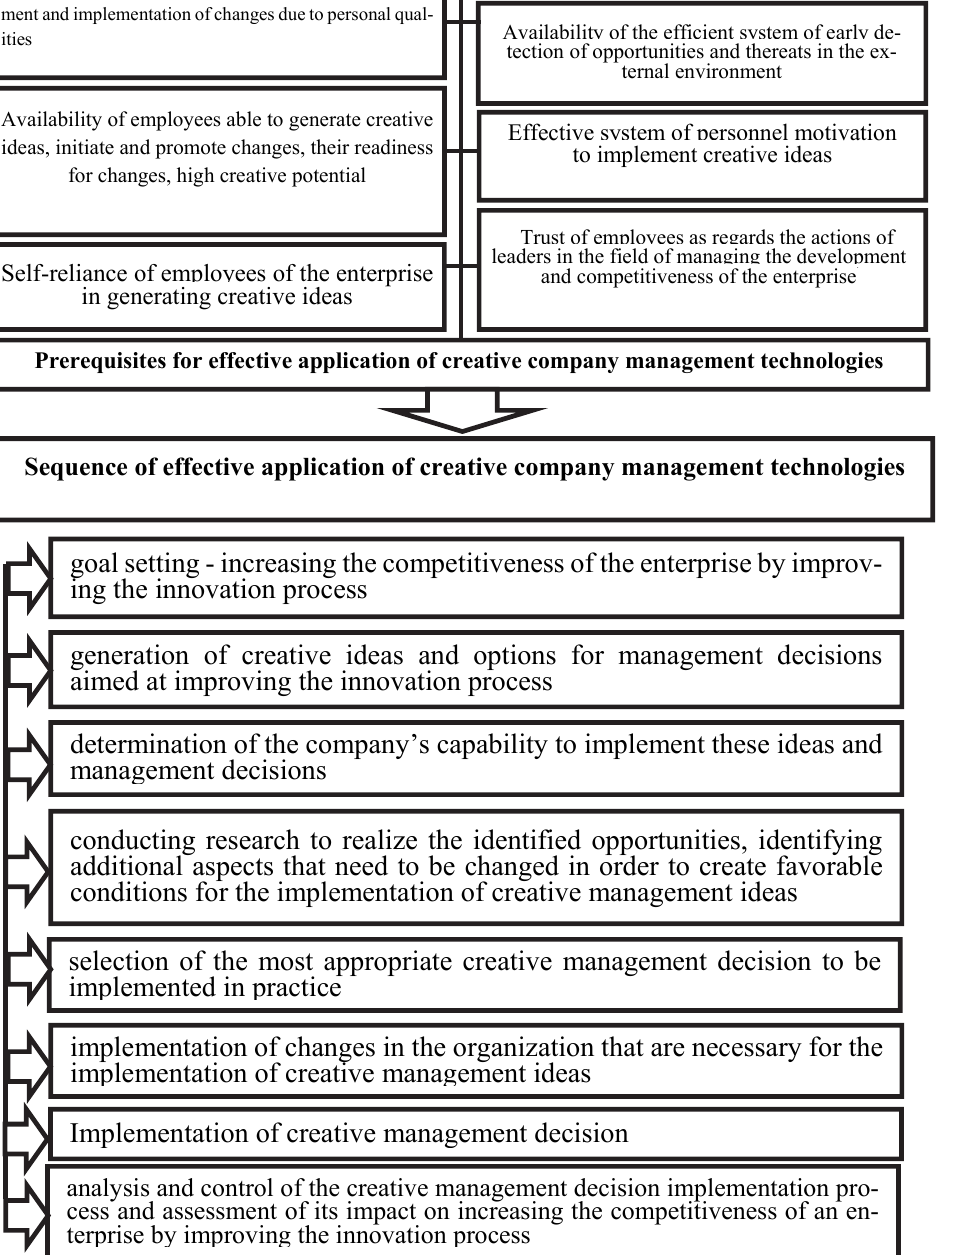
Fig. 3. Prerequisites and sequence of effective application of creative technologies of enterprise management in modern conditions. Source: developed by the author using (Bushuev et al., 2010; Pavlov, 2015; Sokolov  Yurkan,